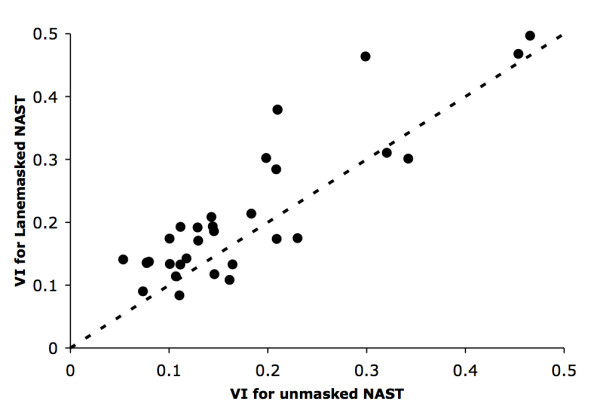
Sensitivity of OTU structure to masking. Comparison of OTU sets constructed with (x-axis) and without (y-axis) the application of a LaneMask to the multiple alignment generated by NAST. Both axes are labeled by the corresponding VI distance from the true species clustering. Overall, masked alignments resulted in poorer concordance to the true data labels. The dashed line is the identity function y = x.